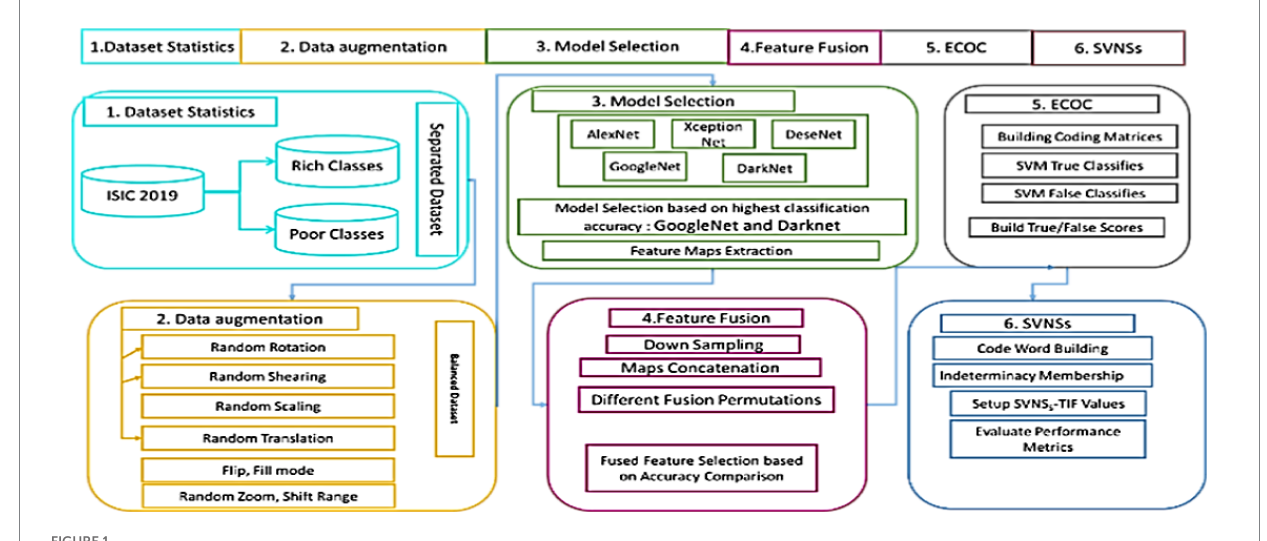
FIGURE 1 Full technique of skin cancer categorization described in this